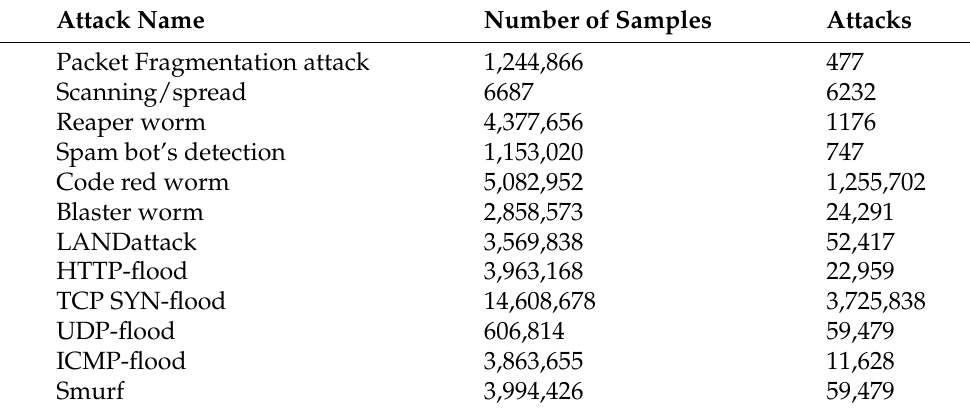
Table 5. Representation of the traffic content of the LITNET-2020 dataset by executed